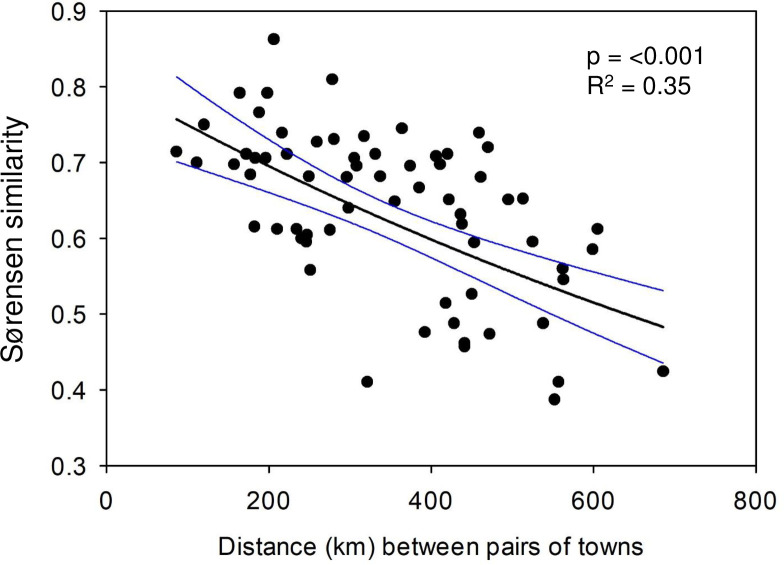
Distance decay relationship, as illustrated by the exponential decay regression of the distance between pairs towns and the corresponding Sørensen similarity of the snail faunas (N = 66).The black line is the regression line and the flanking blue lines are the 95% confidence intervals.